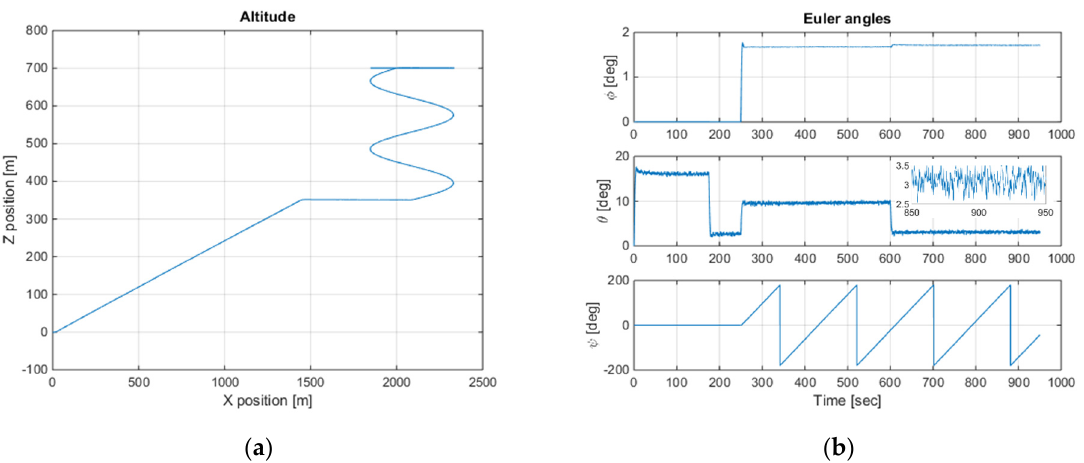
Figure 18. Simulation results: ( a ) Height Profile, ( b ) Euler Angles.